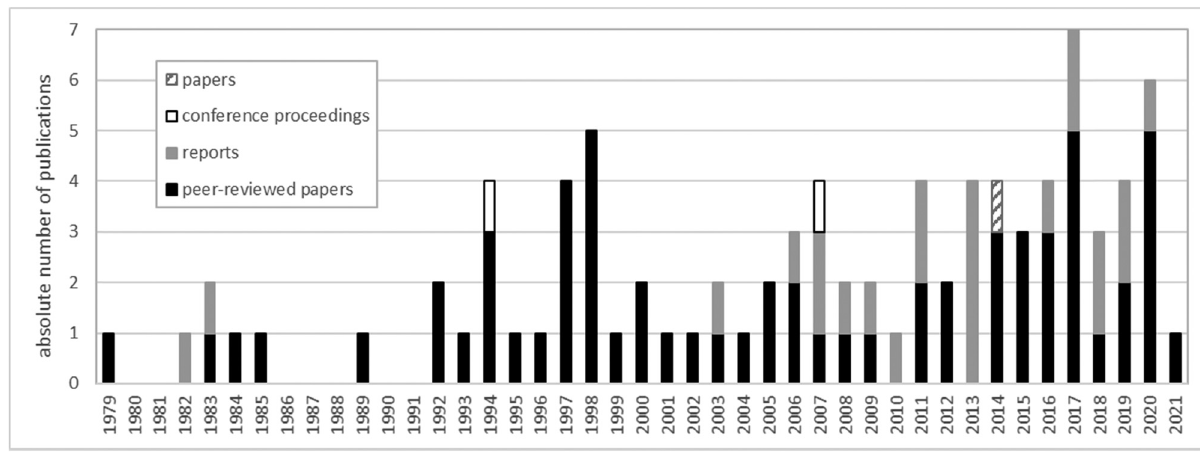
Figure 1: Number of publications per year and publication type, based on the review of refs [ 13 – 98 ]